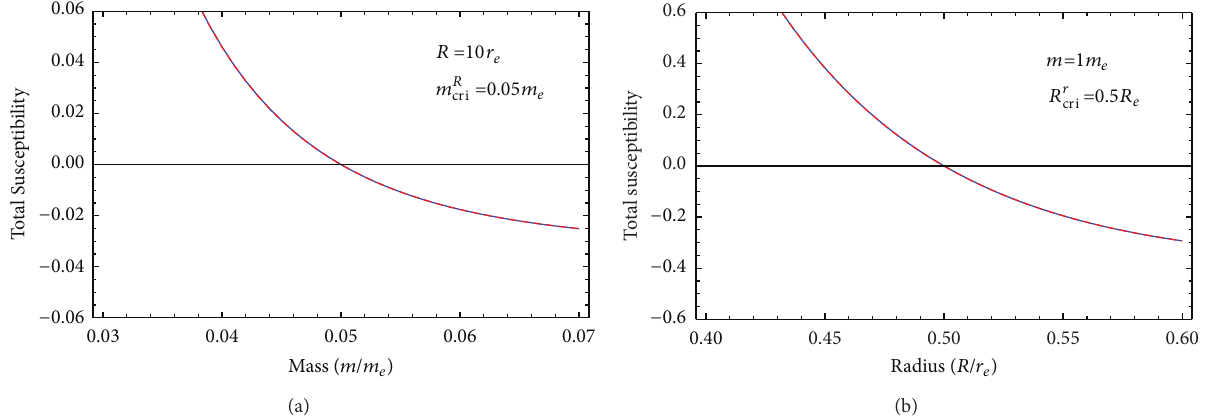
Figure 8: Variation of susceptibility at Φ/Φ 0 = 0 with respect to (a) mass ( 𝑚 ) for a ring with 𝑅 = 10𝑟 𝑒 and (b) ring radius ( 𝑅 ) for 𝑚 = 1𝑚 𝑒 . We have used the same units as Figure 2 and susceptibility is measured in units of Ω 𝑒 (Figure 7). In both cases the susceptibility curve cut the 𝑥 -axis at corresponding critical value, that is, at 𝑚 = 𝑚 𝑅